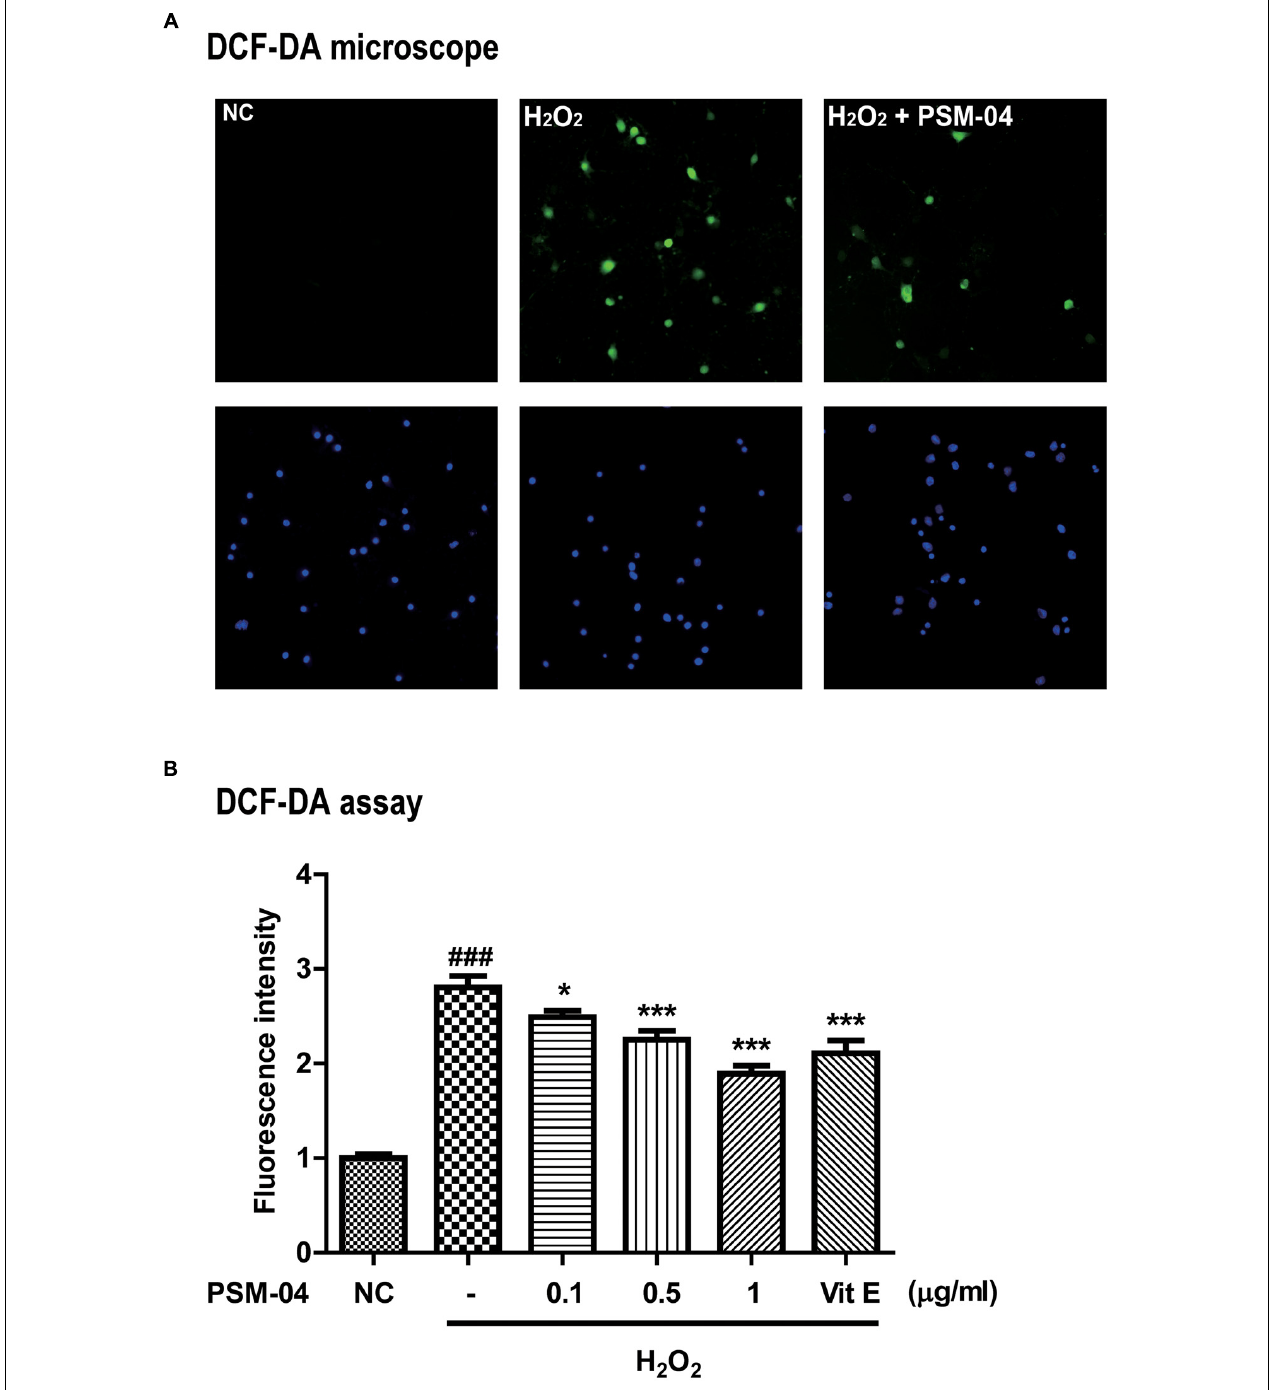
FIGURE 2 | PSM-04 reduced the ROS generated by H 2 O 2 . Primary cortical neurons were treated with PSM-04 (0.1, 0.5, and 1 µ g/mL) at 12 h before 200- µ M H 2 O 2 treatment. ROS production was determined by the DCF-DA assay. (A) Primary cortical neurons were stained with DCF-DA (green), counterstained with DAPI (blue), and visualized via fluorescence microscopy. It was seen that 1- µ g/mL PSM-04 reduced the number of oxidative stress-induced cells by 200- µ M H 2 O 2 treatment. (B) The quantification of DCF-DA fluorescence was shown as a ratio versus the control. PSM-04 or vitamin E significantly reduced the fluorescence intensity (ROS production) induced by 200- µ M H 2 O 2 treatment. All data are given as means ± SEM, and each experiment was repeated five times ( n = 4–6 wells per group, N = 5). The statistical analyses were performed by one-way ANOVA followed by the Newman–Keuls post hoc test. ### p < 0.001 vs. control (NC). ∗ p < 0.05, ∗∗ p < 0.01, and ∗∗∗ p < 0.001 vs. H 2 O 2 only.